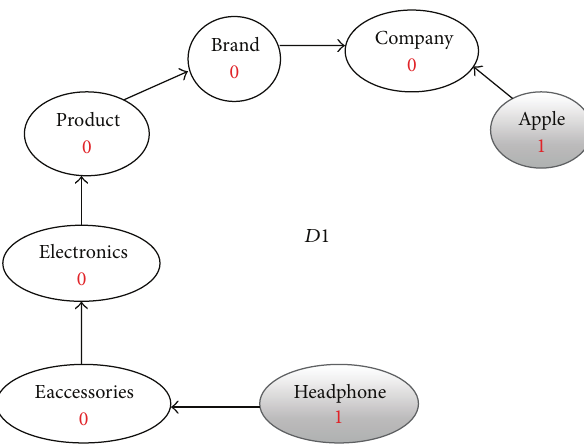
Figure 7: Shortest path for 𝐷1 .